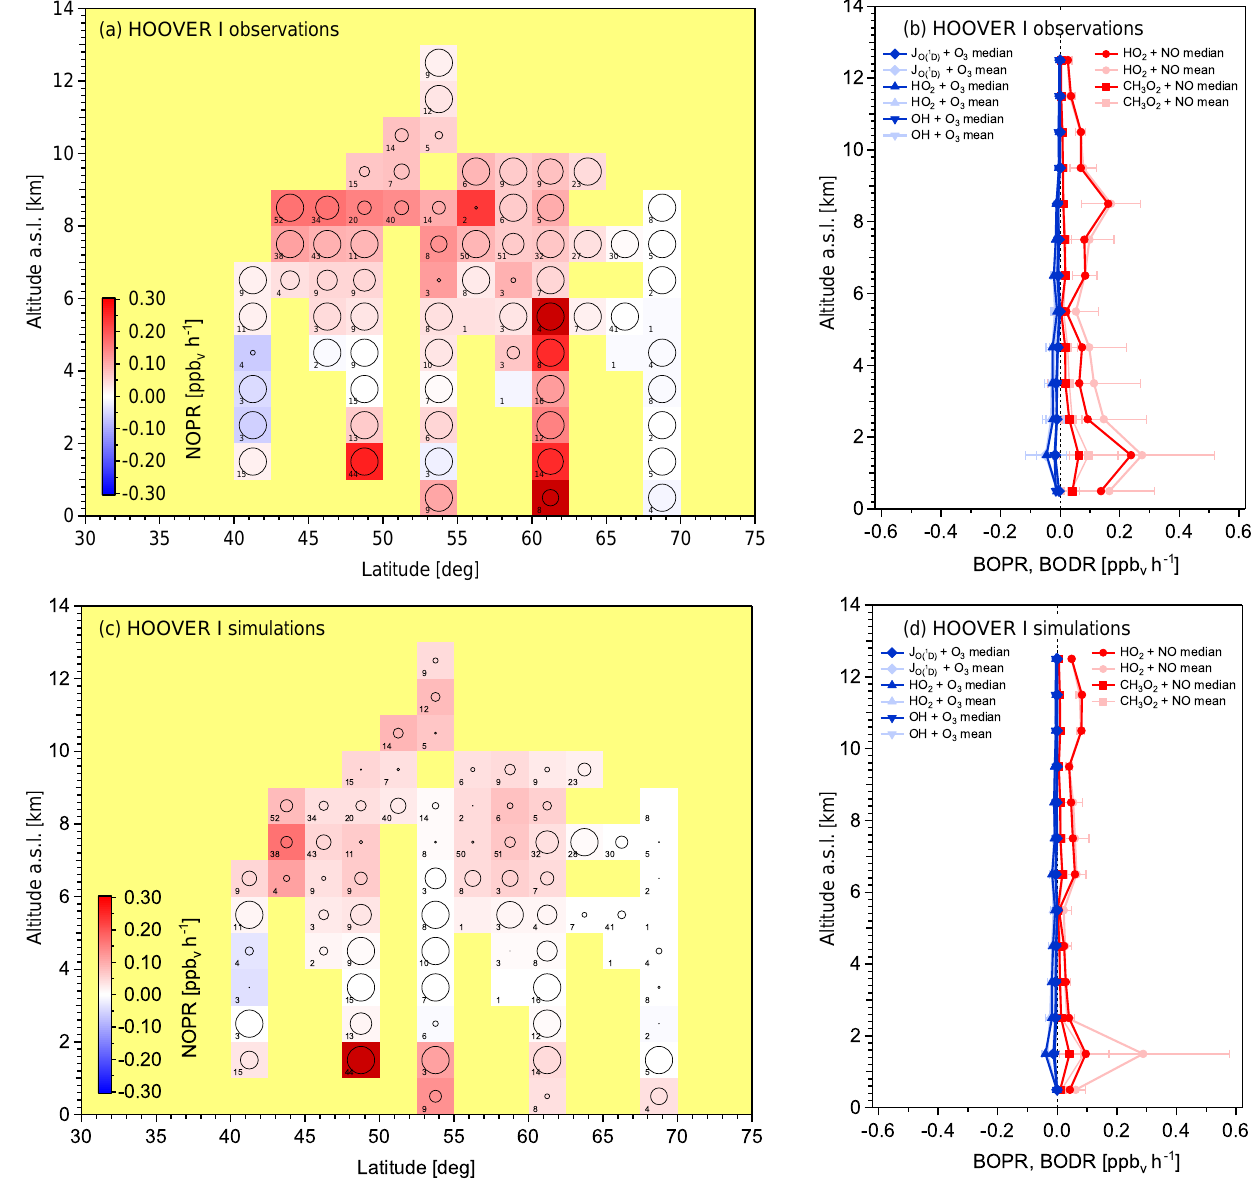
Figure 4. Net ozone production rates (NOPR) in ppbvh − 1 calculated from in situ data (a) and from MATCH simulations (c) for HOOVER I. Altitude profiles of individual production and destruction rates are shown in panel (b) (observations) and panel (d) (model